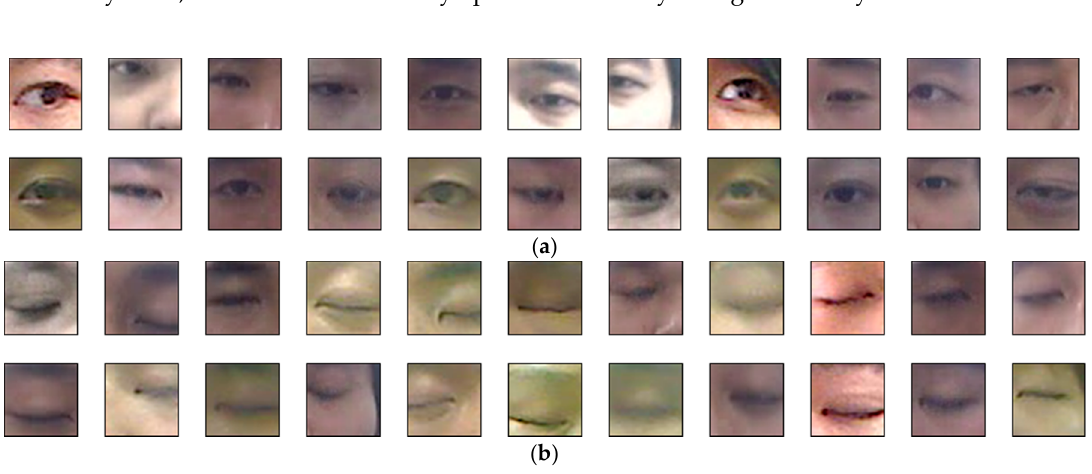
Figure 9. Examples of correct classification of open and closed eye images using the proposed method. ( a ) Open eye images; ( b ) Close eye images.